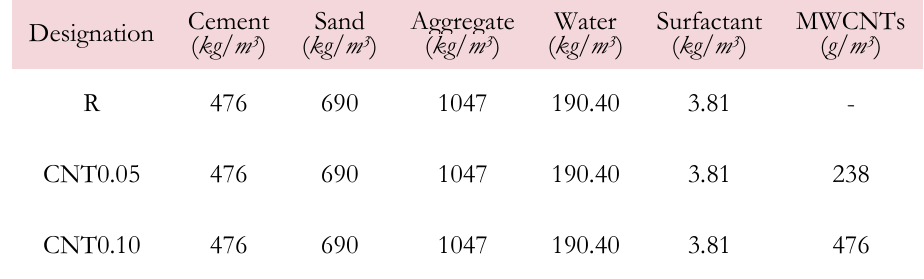
Table 3: Mix proportions of concretes containing